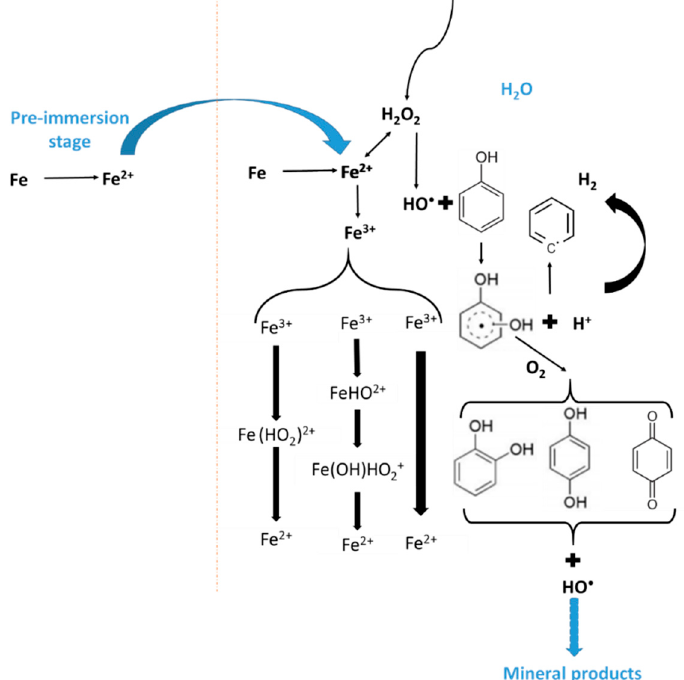
Figure 8. Schematic illustration of the production mechanism of the hydroxyl radical and phenol degradation until mineralization through the Galvano Fenton process without and with the pre- immersion stage.